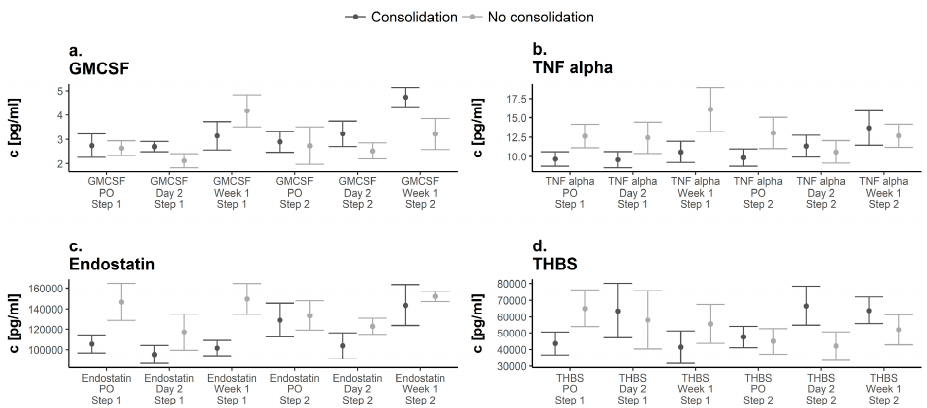
Figure 4. Expression pattern of GM-CSF ( a ), TNF- α ( b ), Endostatin ( c ), and Thrombospondin-2 (THBS) ( d ) over time in both groups. Dark points display Responders, grey points indicate Non-Responders. Significant differences are indicated by a star ( p < 0.05, whiskers are SEM). Abbreviations: preoperatively = PO.